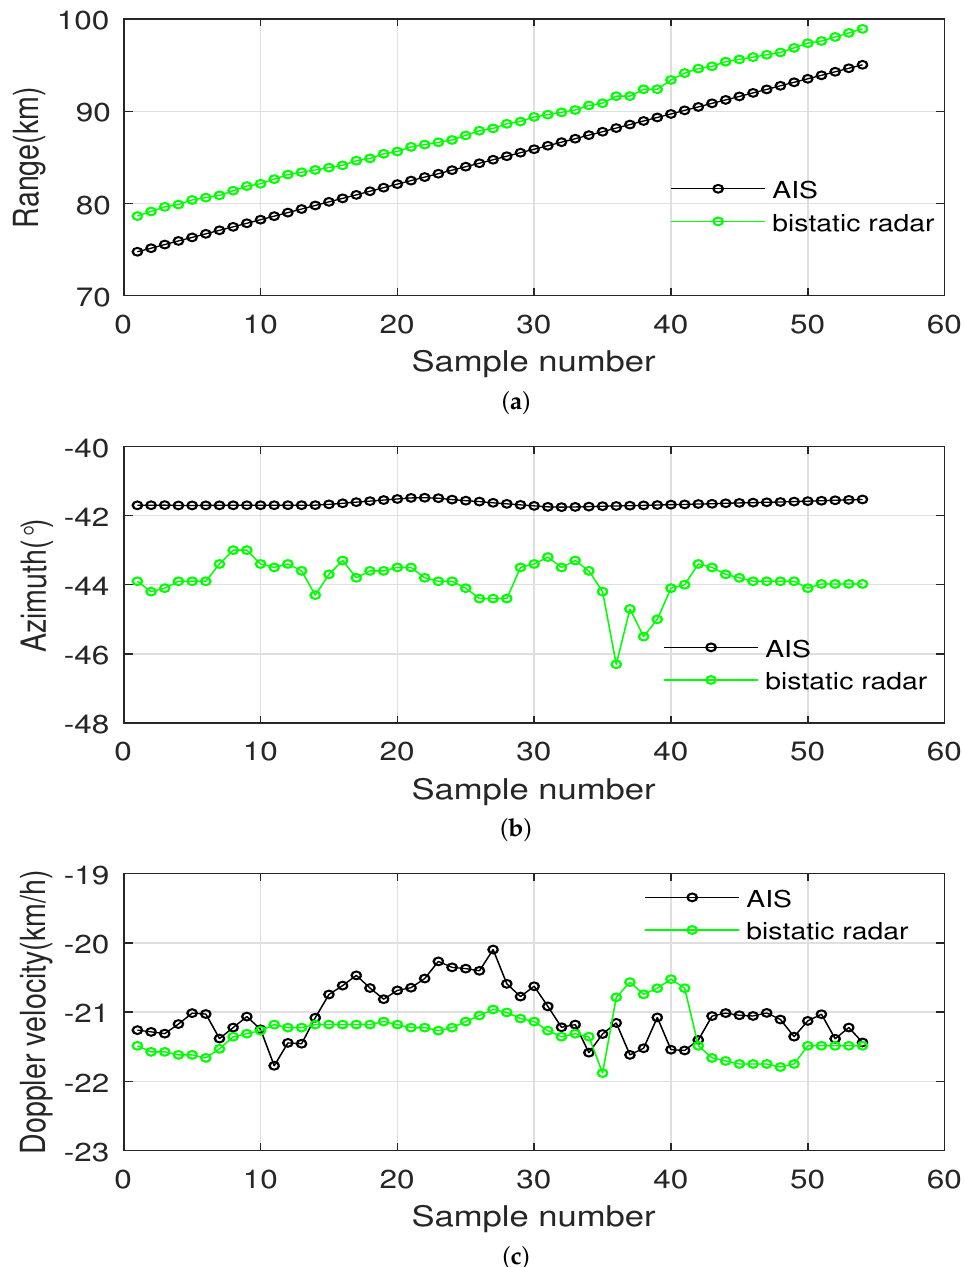
Figure 12. Kinematic parameter comparisons for target 3. ( a ) Range comparison for bistatic radar. ( b ) Azimuth comparison for bistatic radar. ( c ) Doppler velocity comparison for bistatic